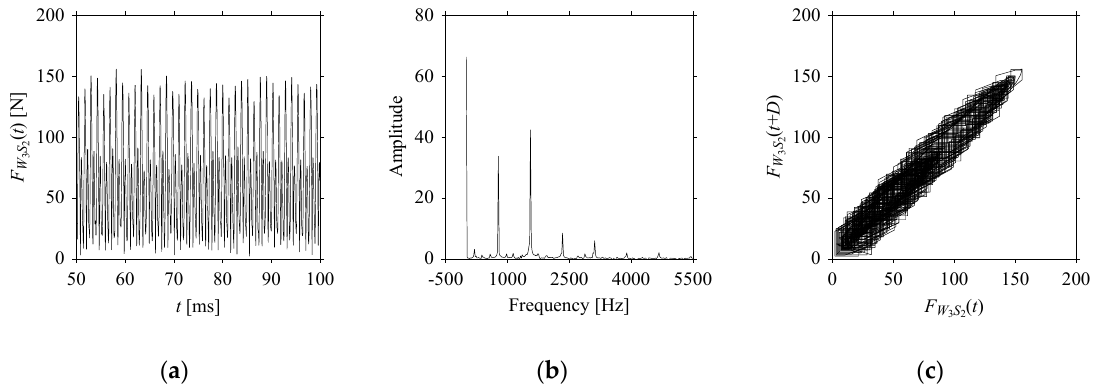
Figure A11. F W in the form of: ( a ) time series, ( b ) fast Fourier Transformation (FFT), and ( c ) delay map ( d = 1). 3 S 2